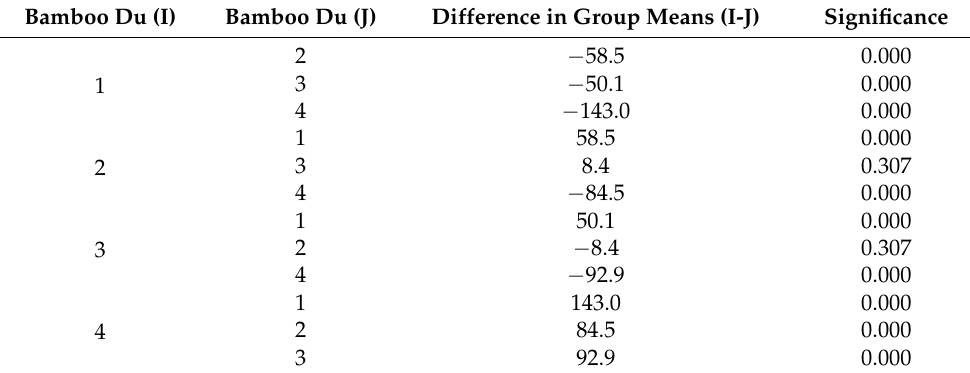
Table 3. Post-hoc test results of one-way ANOVA for comparing each pair of group means. Each group consisted of the average intensity values of individual bamboo culms of the same